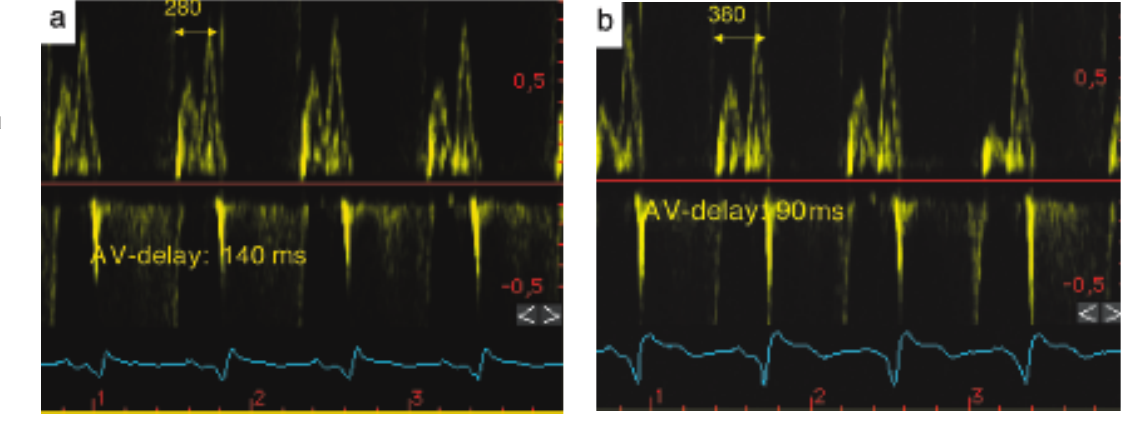
Algorithm for identi- fying biventricular pacing in patients with